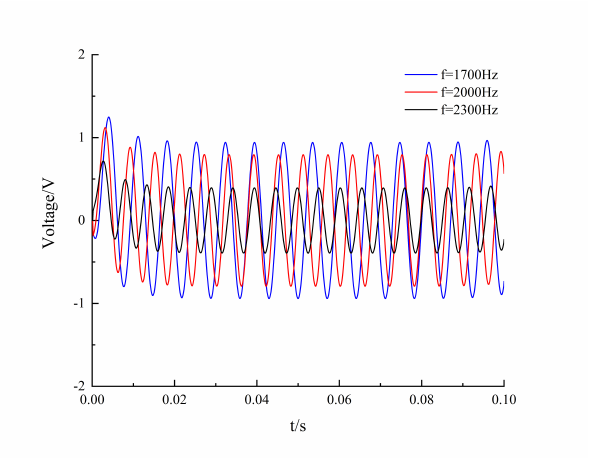
Fig. 9. Transient response of rail surface voltage at different